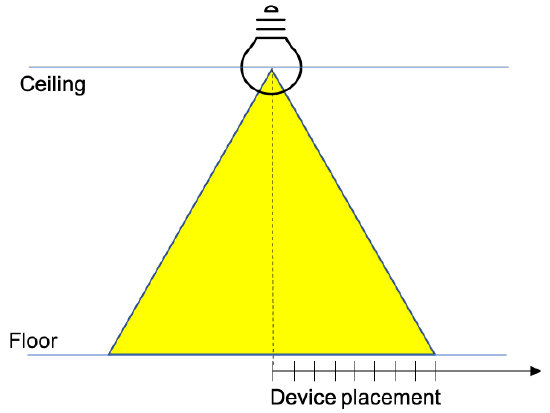
Figure 11. LED lamp coverage cone.